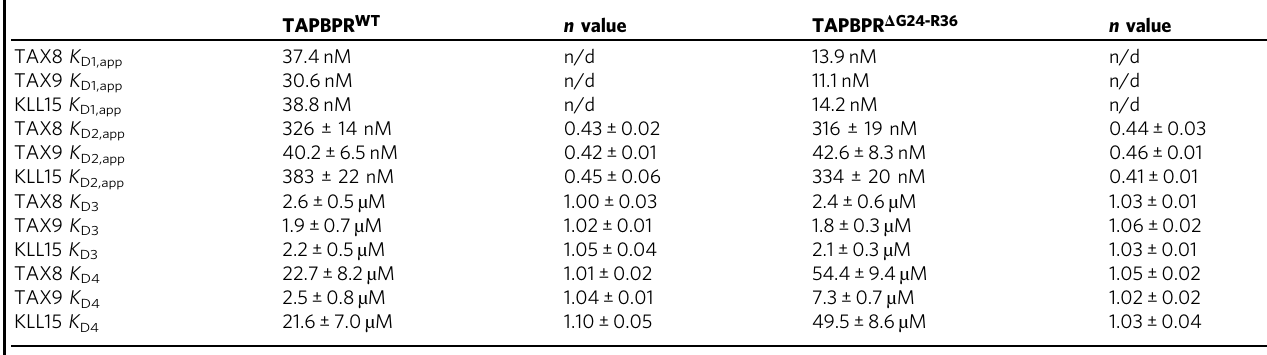
Table 1 ITC derived apparent dissociation constants for each step of the TAPBPR-mediated peptide exchange cycle. TAPBPR WT n